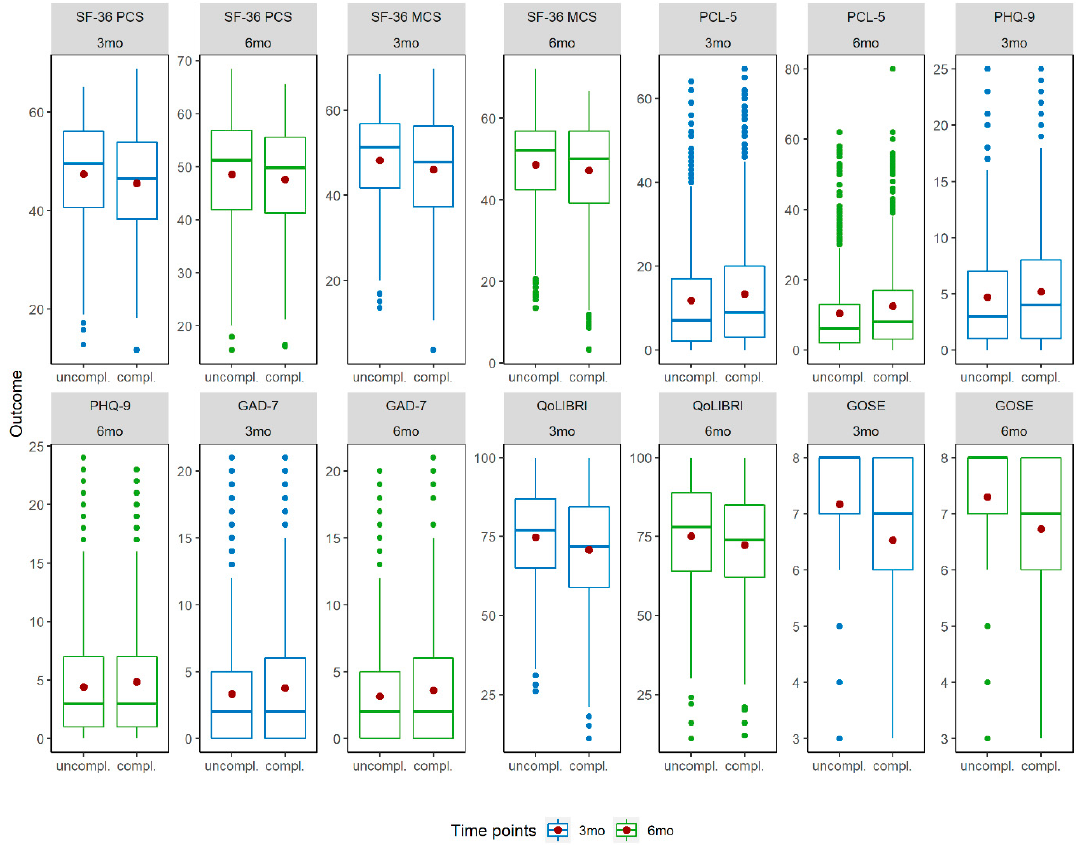
Figure 2. Boxplots for outcomes by time points and uncomplicated and complicated mTBI groups. Note: The Y-axis of the boxplots are adapted to the scales of the outcomes. Red dots within boxplots indicate the mean value. Abbreviations. mTBI = mild traumatic brain injury; SF-36 PCS = Short Form (36) Health Survey (physical component score); SF-MCS = Short Form (36) Health Survey (mental component score); PCL-5 = Posttraumatic Stress Disorder Checklist; PHQ-9 = Patient Health Questionnaire; GAD-7 = Generalized Anxiety Disorder questionnaire; QOLIBRI = Quality of Life after Brain Injury; GOSE = Glasgow Outcome Scale—Extended; 3mo = 3 months; 6mo = 6 months.